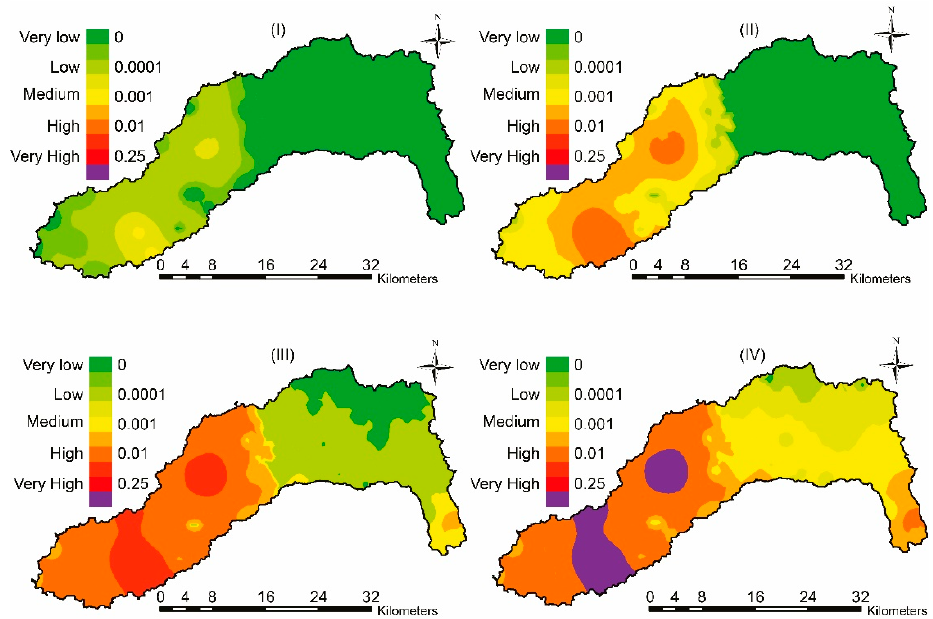
Figure 5 . Leaching potential of Carbofuran in Jazan watershed as assessed by EAF index model under four leaching potential scenarios: low, 0.0003 m d − 1 (I); medium, 0.0005 m d − 1 (II); high, 0.001 m d − 1 (III); and very high recharge rate, 0.002 m d − 1 (IV).